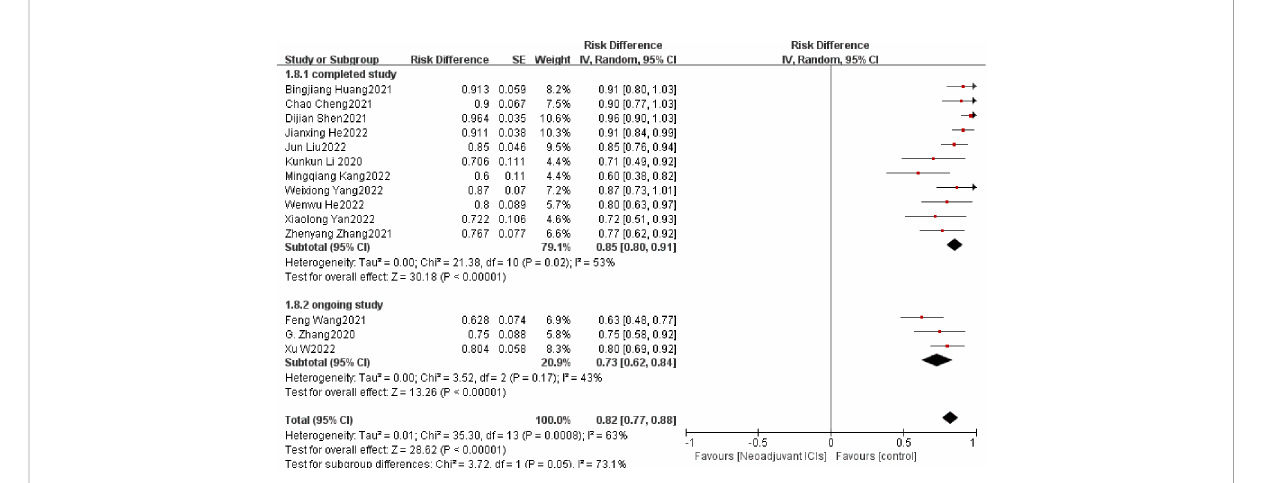
FIGURE 10 Subgroup analysis of the surgical resection